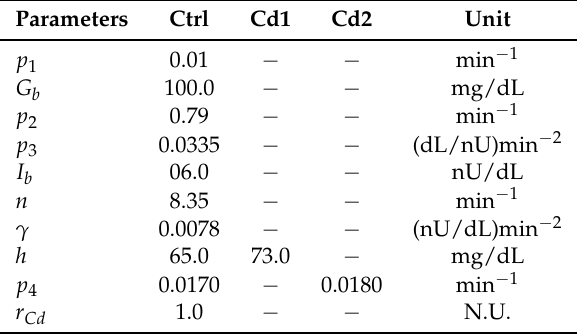
Table 11. Parameter values fitted for the control group as well as groups Cd1 and Cd2 at PND60 (considering Hypothesis 3.3 for Cd2 and Hypothesis 3.2 for Cd1).